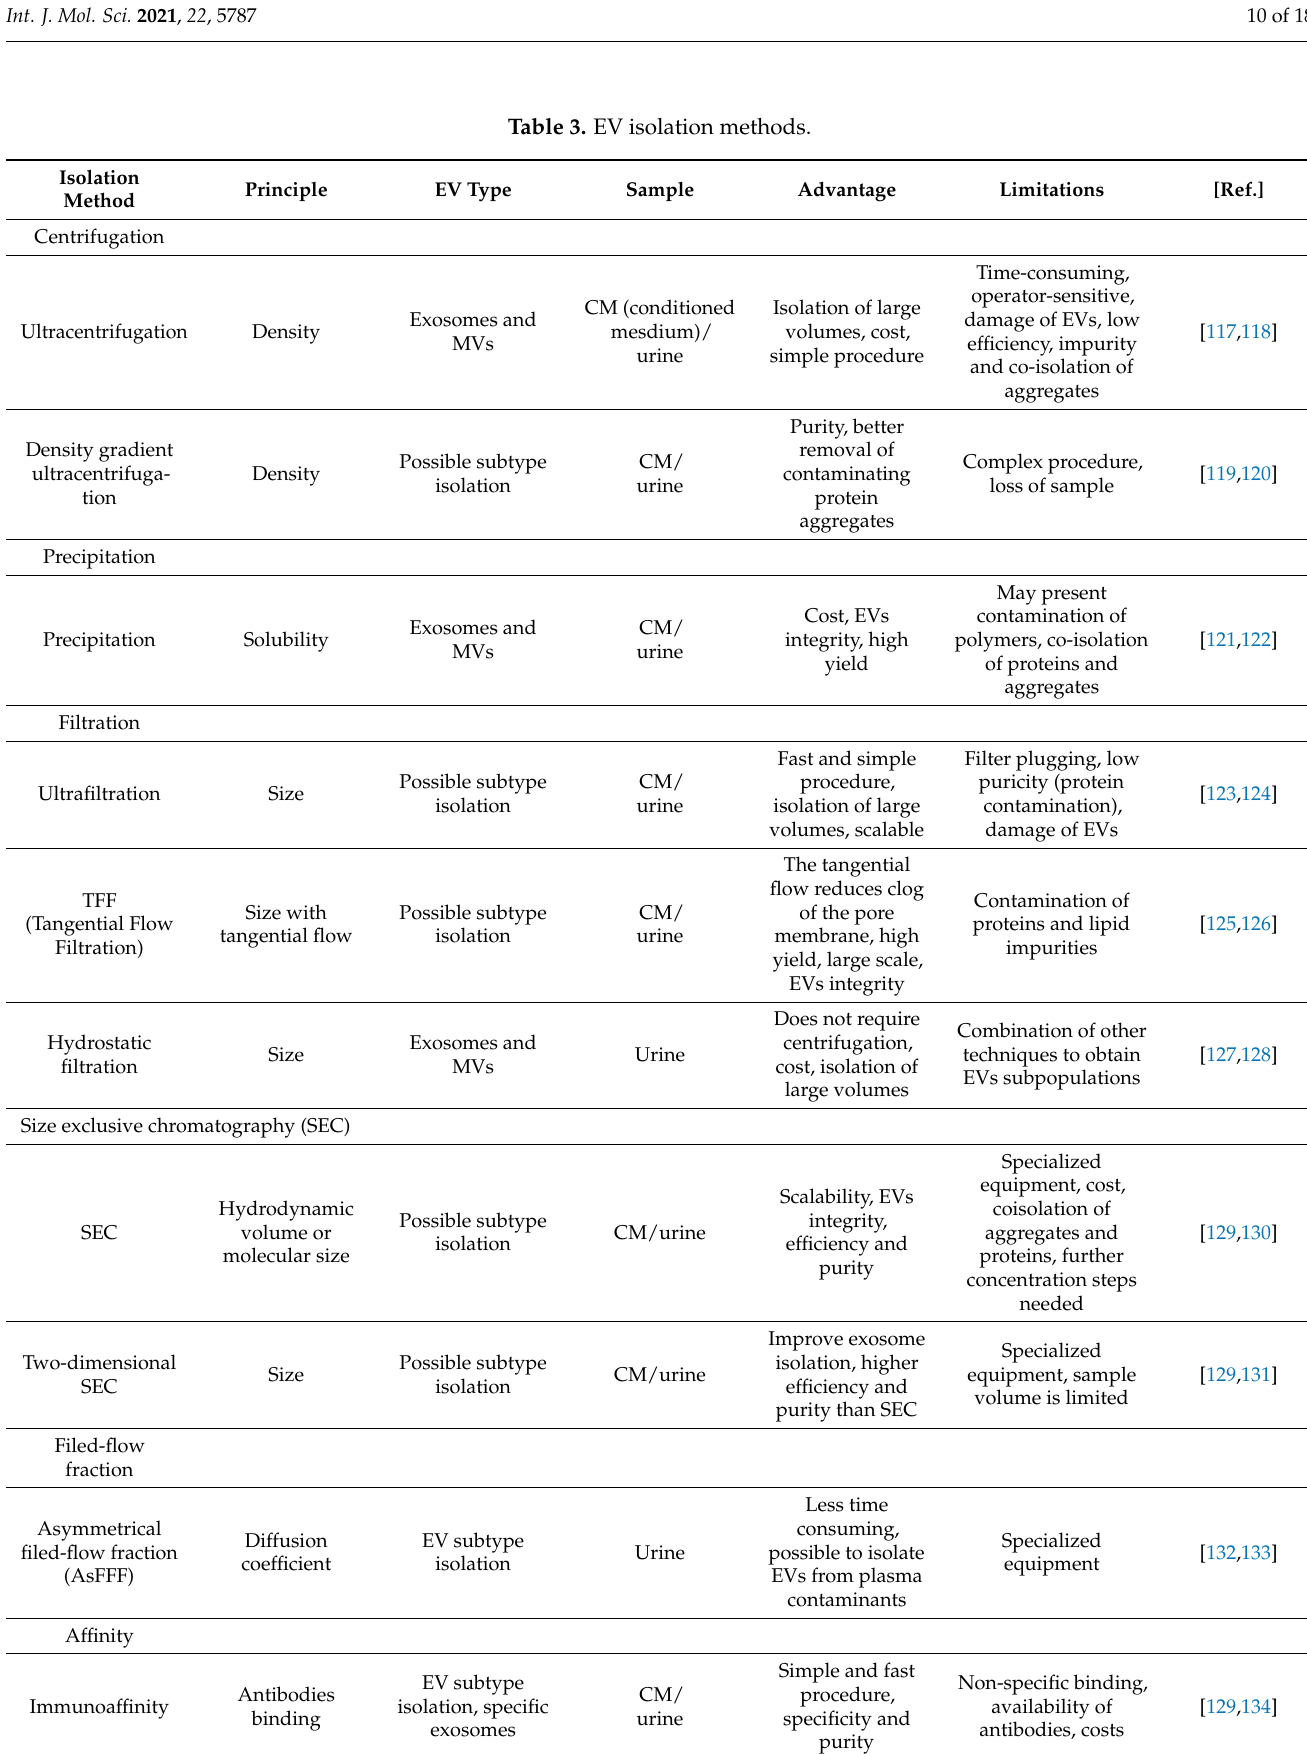
Table 3. EV isolation